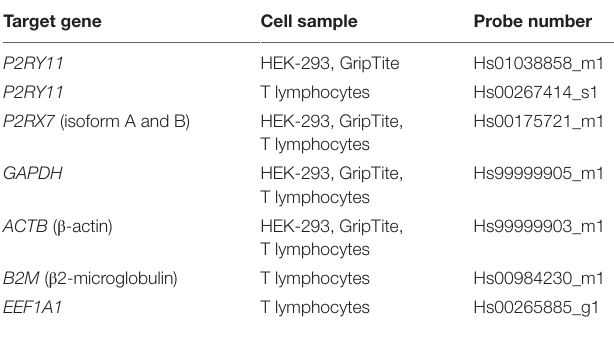
Table 1 | Human TaqMan Gene Expression Assay primer/probes (#4331182, Life Technologies) showing target gene, the cell samples analyzed using the respective primer/probe sets, and their probe